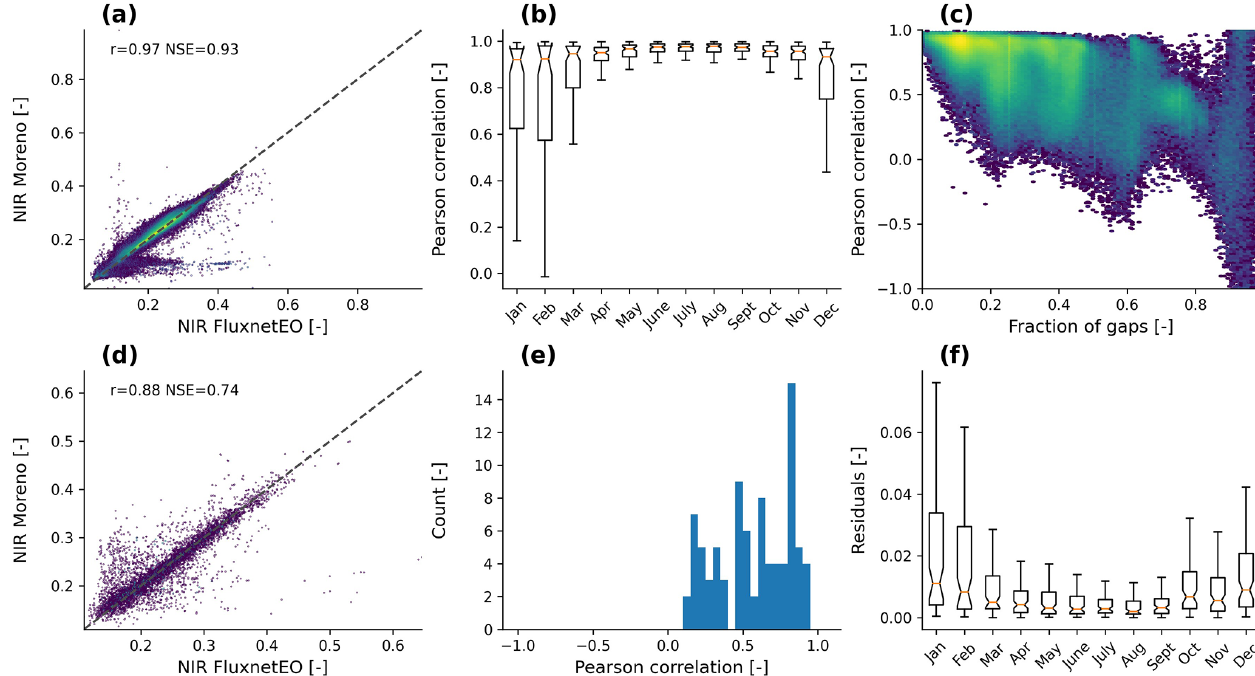
Figure 8. Benchmarking Landsat NIR reflectance from FluxnetEO against the product produced by Moreno-Martínez et al. (2020) at EC sites in the CONUS. Each sample NIR_s,t,p refers to one site ( s ), time step ( t ), and subpixel ( p ). Comparing spatial patterns: (a) scatter- plot of the temporally averaged NIR reflectance (mean_t(NIR_s,p,t), each dot reflects one subpixel and site. (b) Temporal average across years for each month separately and the spatial Pearson correlation across all subpixels in a cutout per site and month cor_p(mean_t- month(NIR FluxnetEO_s,p,t), mean_t-month(NIR Moreno et al_s,p,t)). (c) Temporal correlation as a function of the number of missing values in the FluxnetEO product in each subpixel and site (cor_t(NIR FluxnetEO_s,t,p, NIR Moreno_s,t,p). (d–f) Compute a spatial average across all subpixels in a cutout per time step: NIR ∗ _s,t = mean_p(NIR_s,t,p). (d) Temporal Pearson correlation of the spatially averaged NIR (cor_t(NIR FluxnetEO ∗ _s,t, NIR Moreno ∗ _s,t). (e) Pearson correlation of the deviations from the mean seasonal cycle of the spatially aver- aged time series. (f) Difference between FluxnetEO and Moreno NIR reflectance and their average per month of the year mean_t-month(NIR FluxnetEO ∗ _s,t – NIR Moreno ∗ _s,t). r refers to the Pearson correlation coefficient and NSE to the Nash–Sutcliffe efficiency (Nash and Sut- cliffe,